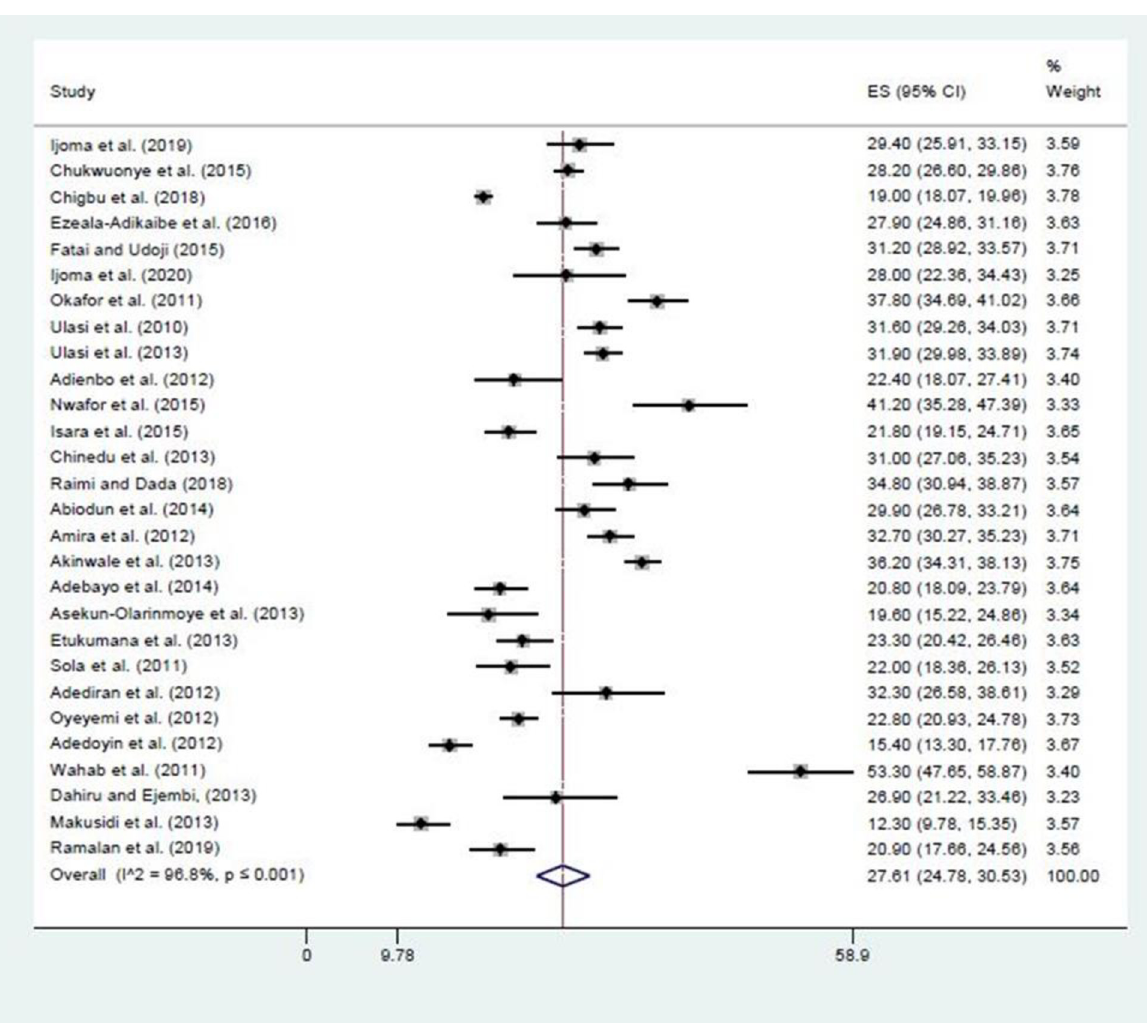
Fig 2. The prevalence of overweight among adults in